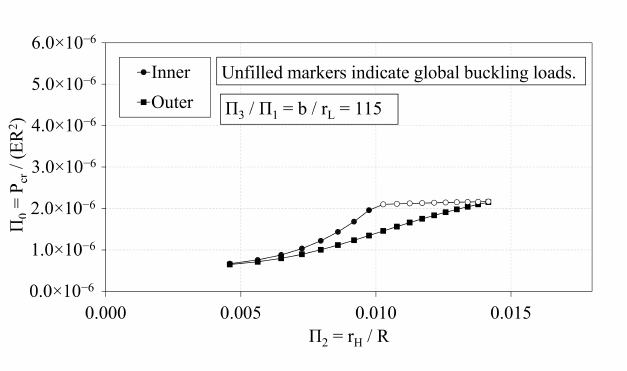
Figure 16. Π 0 vs. Π 2 of OLC and ILC [26].